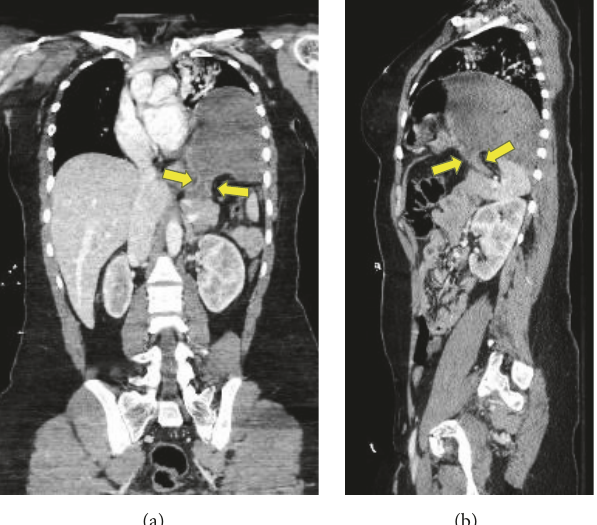
Figure 2: Postcontrast (intravenous) coronal (a) and sagittal (b) CT images illustrate a classic “collar” sign with focal waist-like narrowing of the gastric body (yellow arrows) as it extends from the abdominal cavity into the thorax at the site of diaphragmatic hernia.